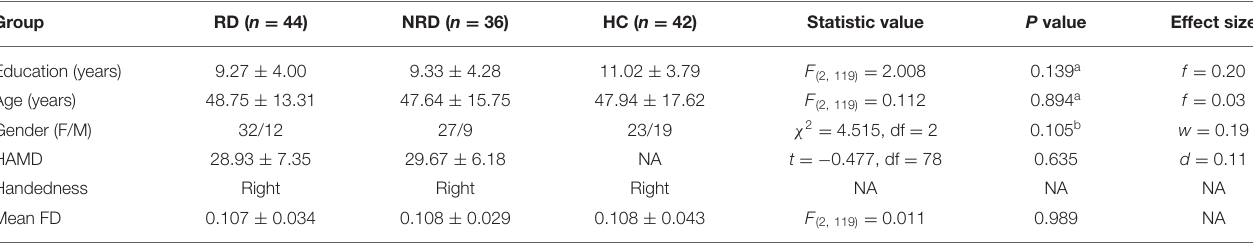
TABLE 1 | Demographic and clinical characteristics of all participants (mean ±